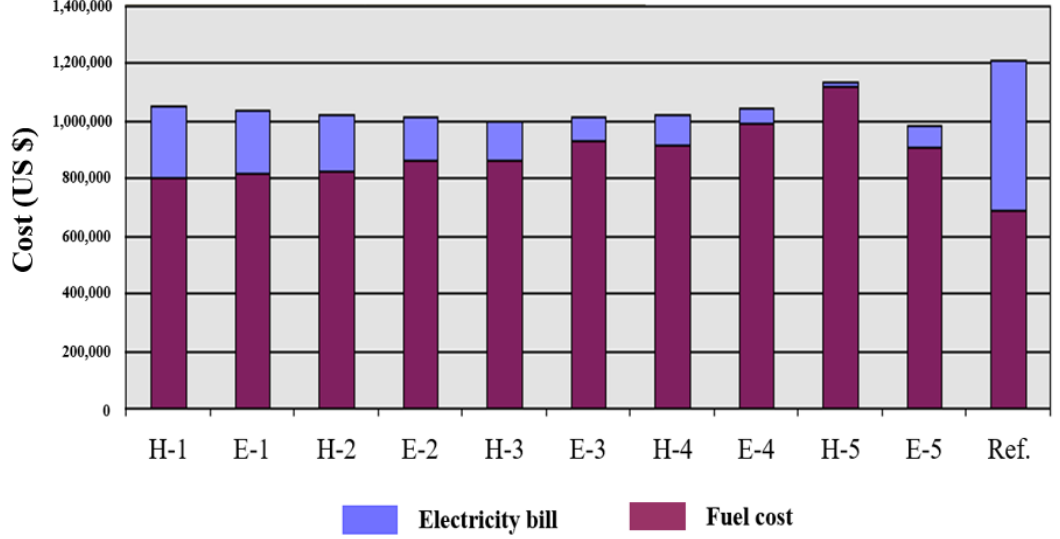
Figure 9. Comparison of the simulated operational cost – benefit in Case A.